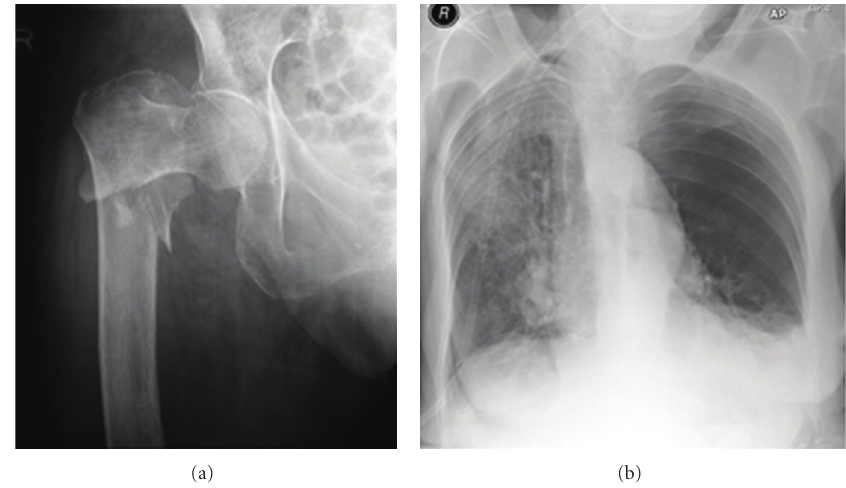
Figure 23: A hip and chest radiograph on an 87-year-old woman following a fall showing a fracture of the neck of the right hip. The CXR was interpreted as showing a left-sided pneumothorax, and thus, a chest drain was put in place (see Figures 25 and